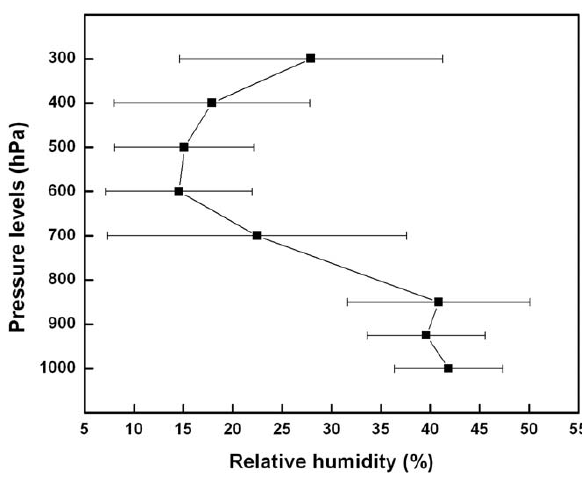
Fig. 8. Mean relative humidity (RH) profile from NCEP and its standard deviation, during the LC-II period averaged over the study domain.